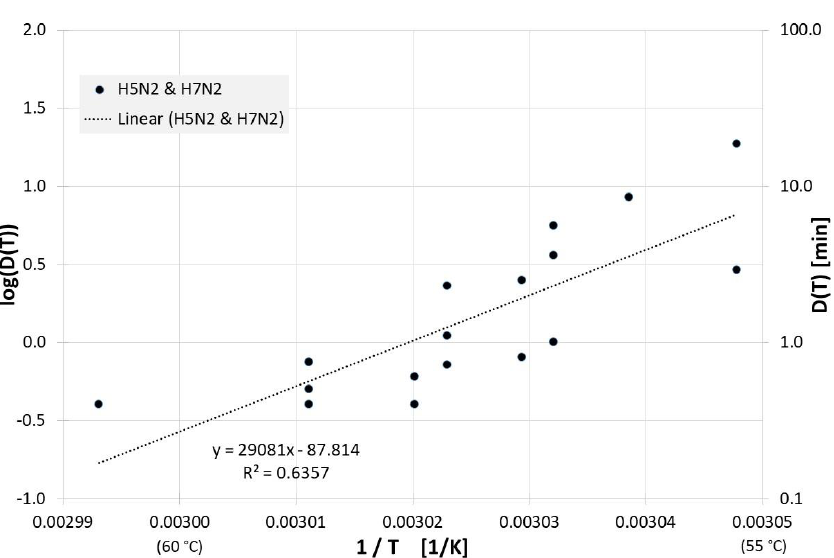
Figure 10. Correlation between 1/T and log(D(T)) for all published influenza virus thermal inactiva- tion data in in fat free egg and egg substitutes along with the linear regression curve. For better understanding, D(T) is also given on the right Y-axis in a logarithmic scale. In the event of an influenza outbreak, waste products must also be contaminated.